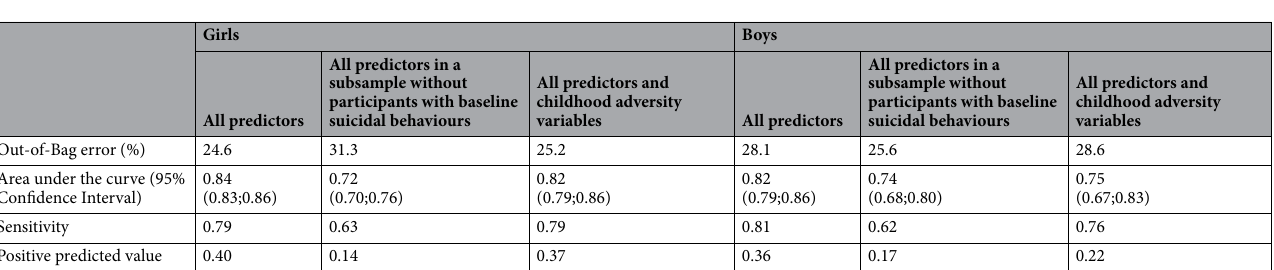
Table 2. Predictive performances metrics.